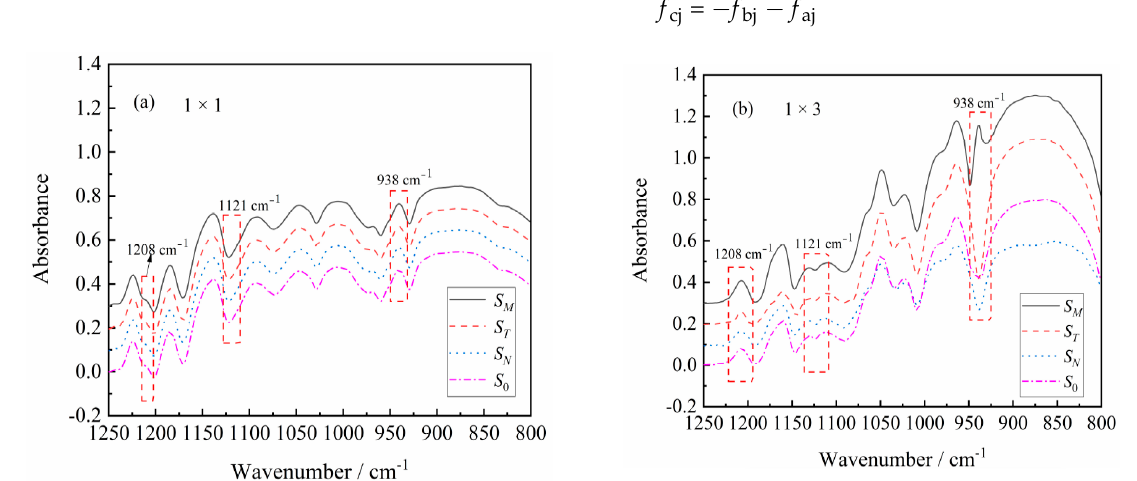
Figure 4. FTIR spectra of the crystal phase along the TD, MD, calculated ND and structure factor spectrum ( S 0 ) for ( a ) 1 × 1 and ( b ) 1 × 3 stretched films.